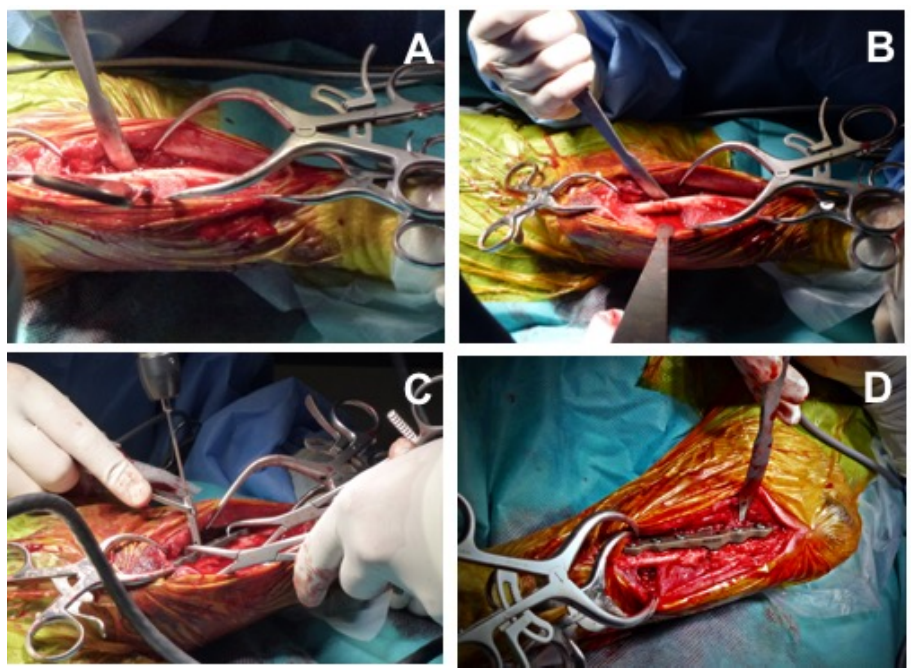
Figure 1. Surgical procedure: Proximal Abduction Ulnar Osteotomy (PAUL) technique. ( A ) Cau- dolateral approach at the level of the proximal third of the ulnar diaphysis. ( B ) Ulnar osteotomy in the proximal third of the ulnar diaphysis. ( C , D ) Location and fixation of the Advanced Locking Plate System (ALPS) plate in proximal and lateral ulna.